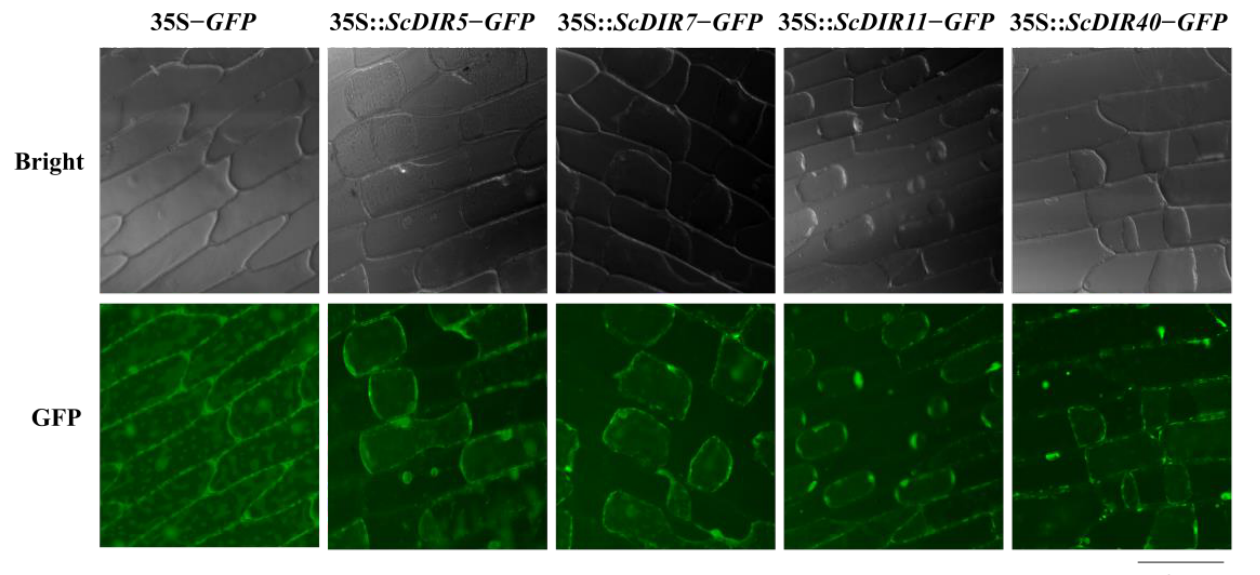
Figure 3. Protein sequence analysis, conserved domains, and tertiary structures of ScDIR5, ScDIR7, ScDIR11, and ScDIR40. ( a ) protein sequence alignment. ( b ) conserved protein motifs predicted with MEME Suite software. ( c ) DIR domain. ( d ) tertiary structures of the ScDIRs predicted using SWISS−MODEL online software, using PsPTS1 as a template. Two structures were predicted in ScDIR40, one of them (right−most) may not be functional.